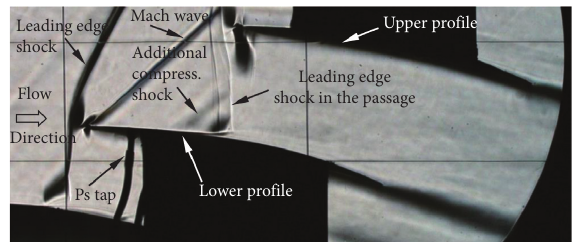
Figure 4: Schlieren flow visualization for reference laminar interaction.